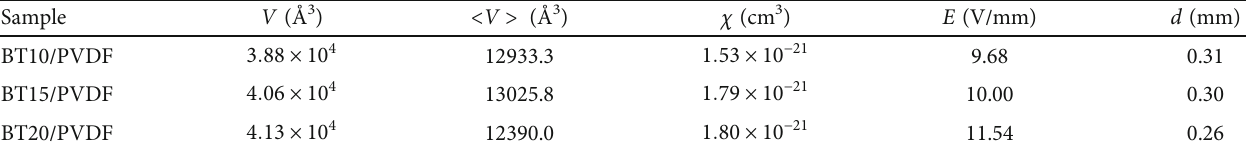
Table 5: Calculated parameters for MD simulations of BT/PVDF